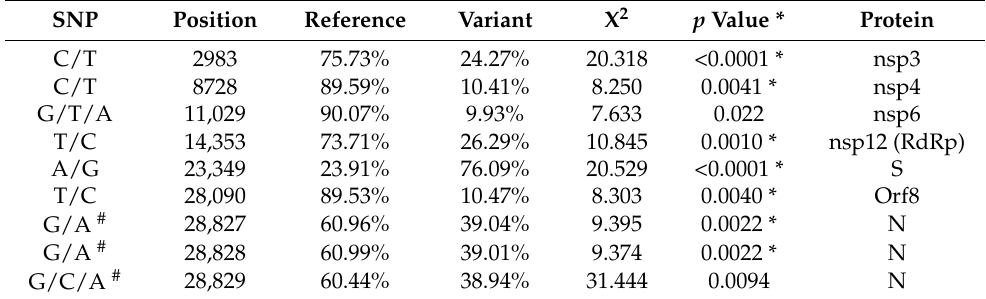
Table 3. SNPs of SARS-CoV-2 and their association with patient mortality in the validation cohort. SNP